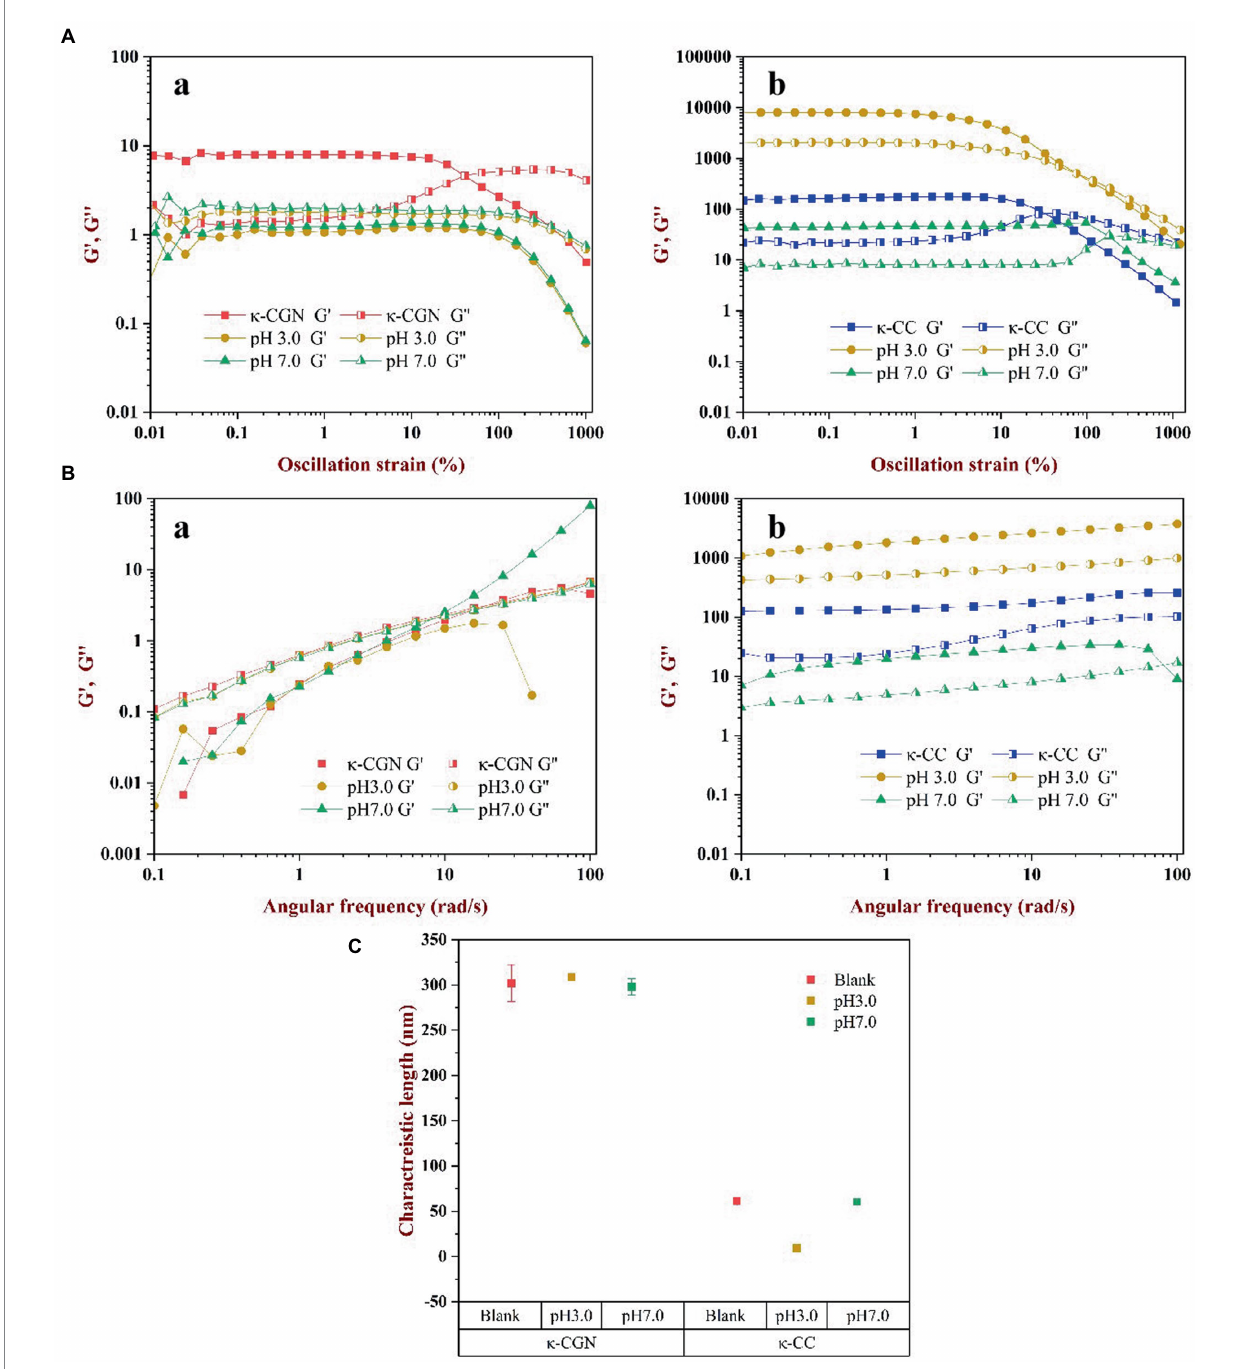
FIGURE 4 The effects of physiological pH on the rheological characterization of κ -CGN and κ -CC. Dynamic oscillatory measurements were used to show the nonlinear rheology behaviors (A) ; Frequency sweep test were conducted to analyze the relation of angular frequency and the dynamic moduli (B) ; The characteristic length of elastically active chain was calculated to reflect the intermolecular elasticity (C)